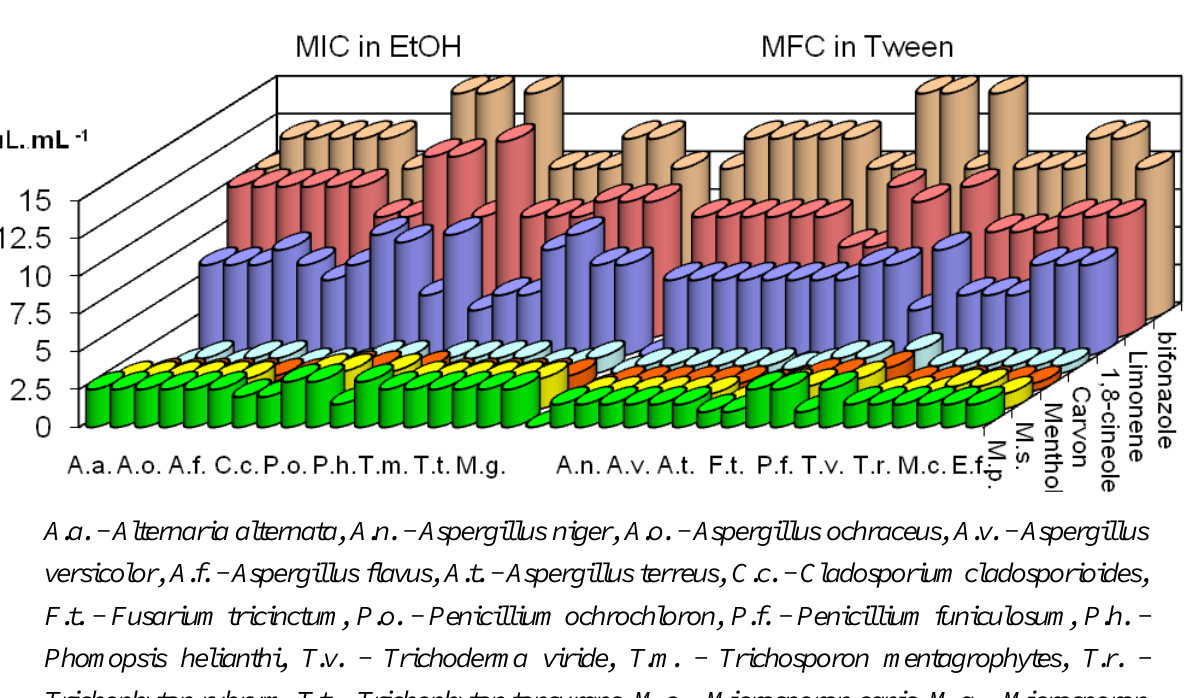
Figure. 2. MIC ( μ L·mL -1 ) in EtOH (macrodilution method) of oils of M. piperita and M. spicata and their components and MFC (µL·mL -1 ) in Tween ® (microdilution